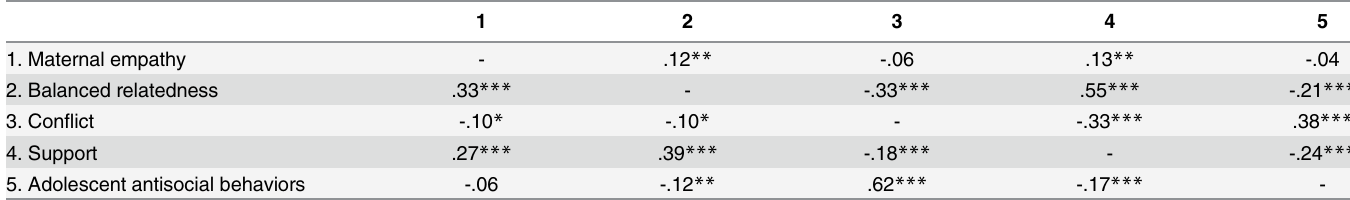
Table 2. Bivariate Correlations among Study Variables at Time